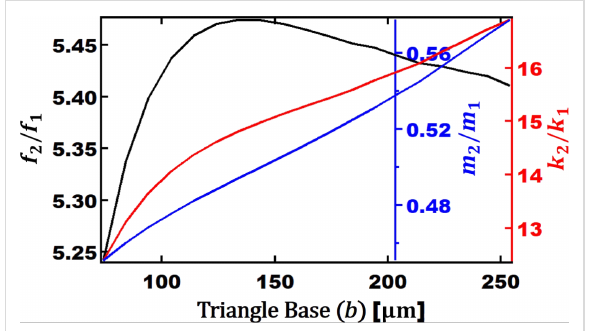
Figure 5: Ratio of second eigenmode to first eigenmode as a function of the triangle base width ( b ) of V-shaped cantilevers for: frequency (black axis), mass (blue axis), and stiffness (red axis). The other geometrical parameters are: L opt = 90 µm, = 15 µm, and t ref = 0.4